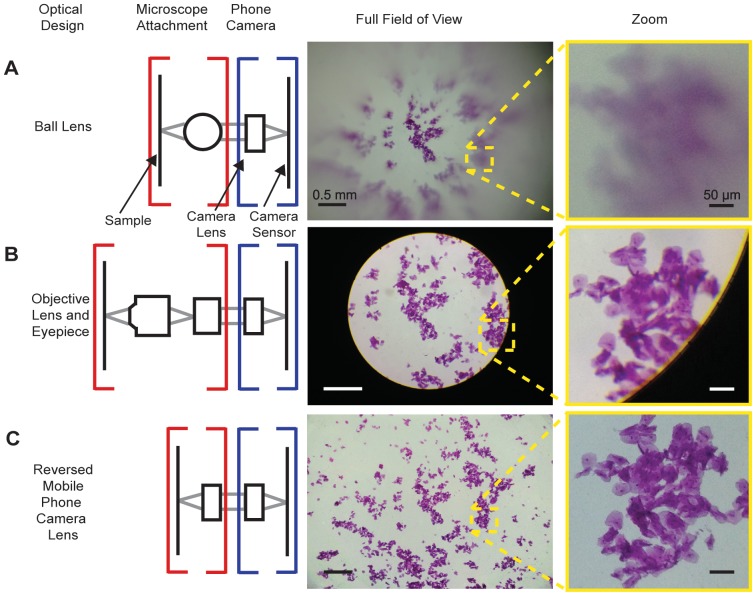
Comparison of mobile phone microscopes.A) Left panel: Cartoon schematic of a ball lens mobile phone microscope. Red brackets indicate microscope attachment optics outside of the phone (a ball lens), and blue brackets indicate mobile phone camera optics inside the phone (a lens group and CMOS sensor). Middle panel: Image of stained cheek epithelial cells taken with a 6 mm ball lens. Right panel: Enlargement of the area indicated within the dashed line in the middle panel. B) Left panel: Cartoon schematic of a standard finite objective microscope attachment to a mobile phone, consisting of an objective and an eyepiece. Middle panel: Image of stained cheek epithelial cells taken with a 4X/0.10 NA objective and a 20X eyepiece. Right panel: Enlargement of the area indicated within the dashed line in the middle panel. Note that despite the image being in-focus at the center of the field of view, some image degradation due to field curvature is detectable at the edge of the field. C) Left panel: Cartoon schematic of the reversed lens microscope presented in this paper, with opposing identical lens groups outside the phone (red brackets) and inside the phone (blue brackets). Middle panel: Image of stained cheek epithelial cells taken with the opposed lens group setup. Right panel: Enlarged area of the area indicated within the dashed line in the middle panel. Note that despite the image being focused at the center of the field, no field curvature is detectable in the reversed lens microscope image, in contrast to the ball lens A) and standard finite objective B) microscope images.